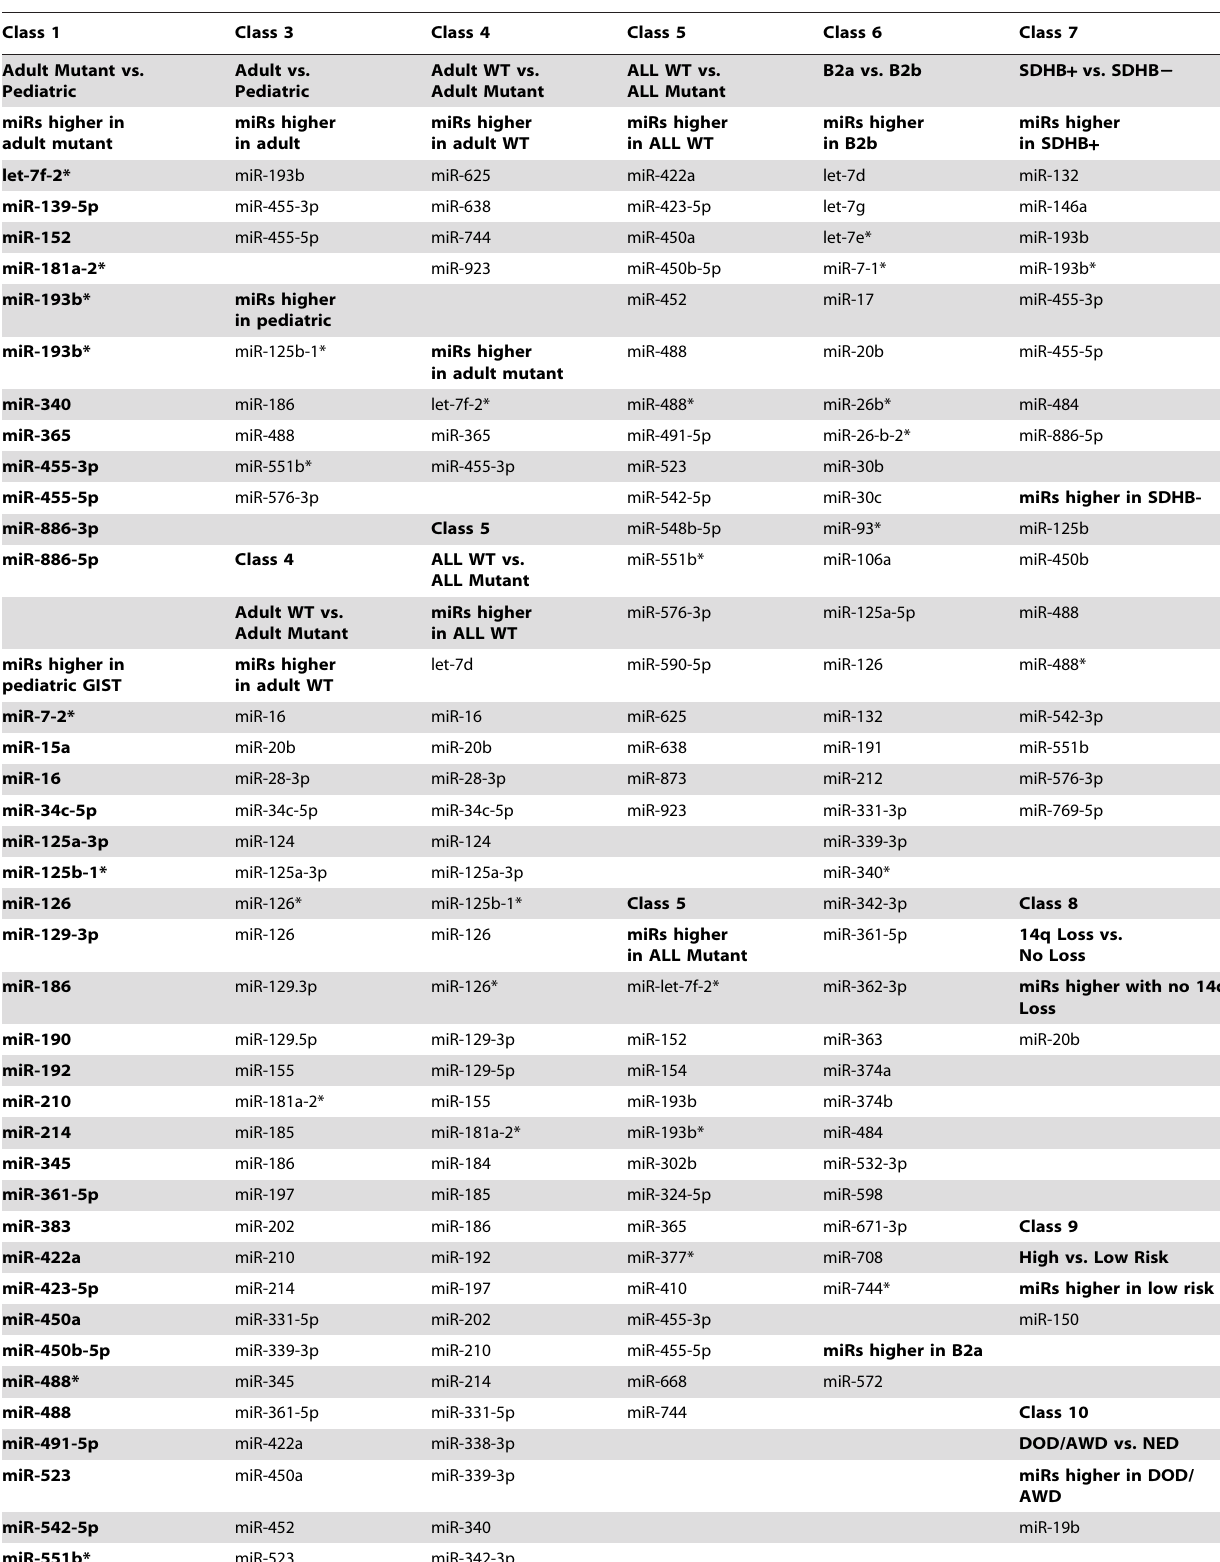
Table 4. Significantly differentially expressed miRNAs between the various classes of